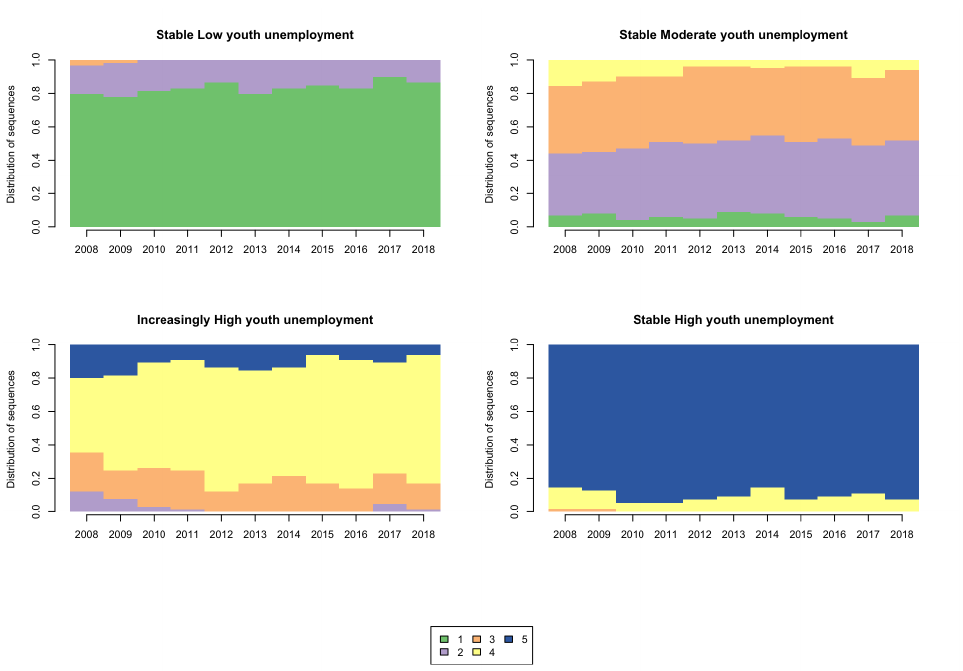
Figure 5: Distribution plot by sequence